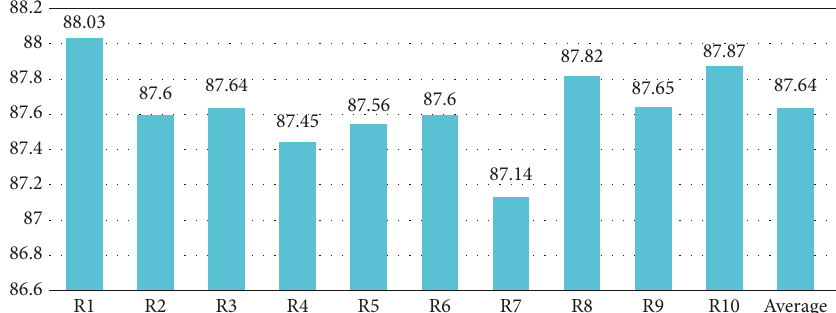
Figure 8: Results of 10 runs of the proposed method in the classification recall F_measure with an average of 10 runs.